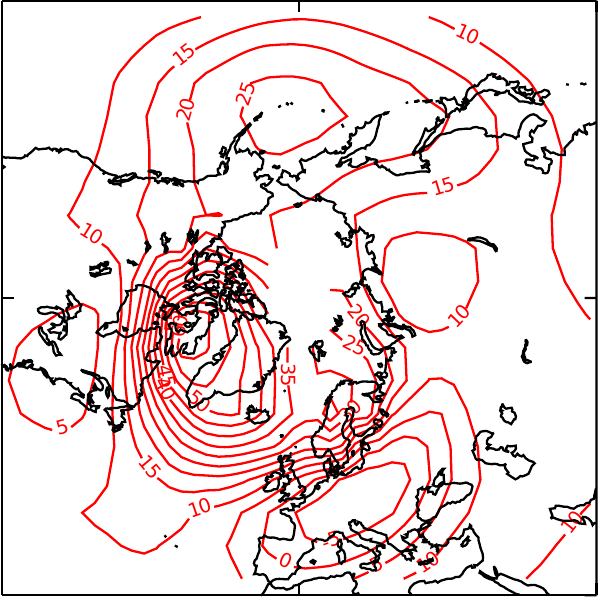
Fig. 11. Difference in 500hPa geopotential height (m) between the final steady state and the time-mean of years 1–100 of the syn- chronously coupled experiment for the incipient glacial climate (fi- nal minus